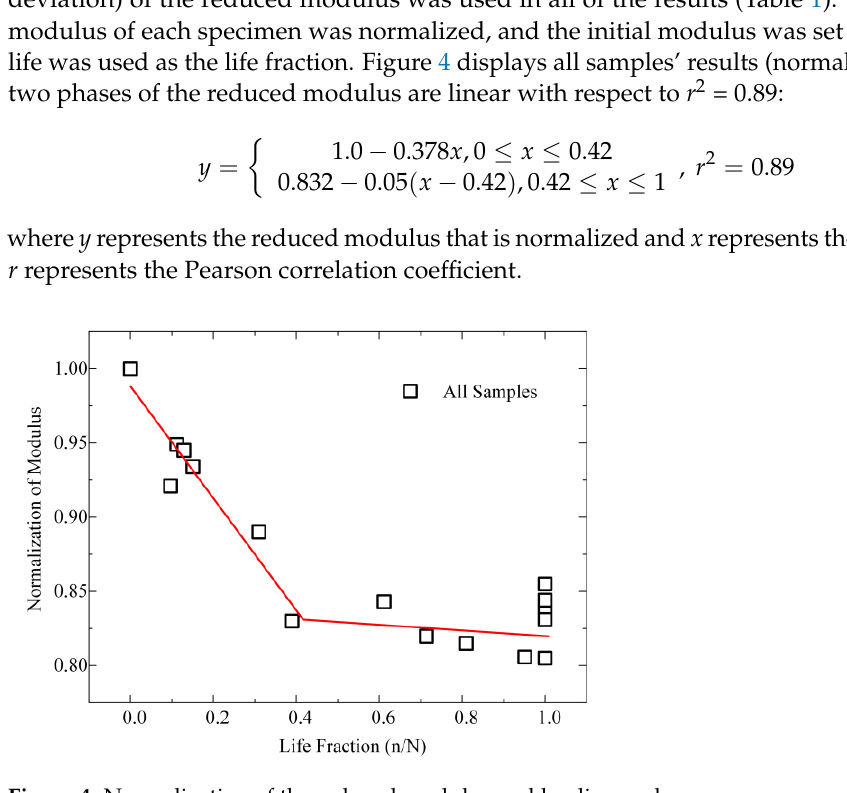
Figure 3. The residual indentations and fatigue damage under optical microscope and SEM. ( a ) SEM image of the indentations; ( b ) Linear cracks; ( c ) Diffuse damage; ( d ), ( e ) & ( f ) Optical micro- scope images of the indentations; ( g ) The fracture surface and the test area. Compared with the damage due to fatigue loading, the damage caused by indentations could be ignored.